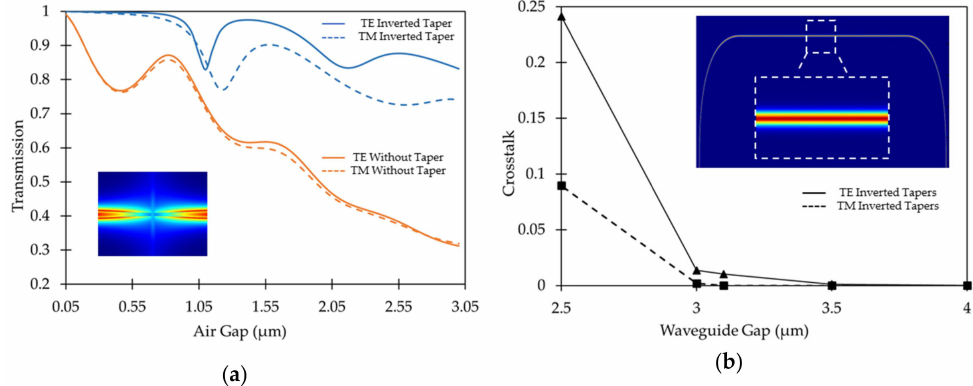
Figure 2. Optical simulation results for: ( a ) EME analysis showing transmission e ffi ciency for TE and TM modes between two butt-coupled SiN waveguides as a function of air gap with and without inverted tapers. The inset shows the top-view of the magnitude of the electric field of TE mode for butt-coupling with inverted tapers at a gap of 500 nm; ( b ) 2.5D FDTD analysis showing cross-talk for TE and TM modes as a function of the gap between two SiN waveguides with 90 ◦ bends and 75 µ m bending radius. Inset shows top-view of the magnitude of electric field of TE mode for the complete optical path with two parallel SiN waveguides at a gap of 3.1 µ m. Image shows that the field remains completely confined in the input